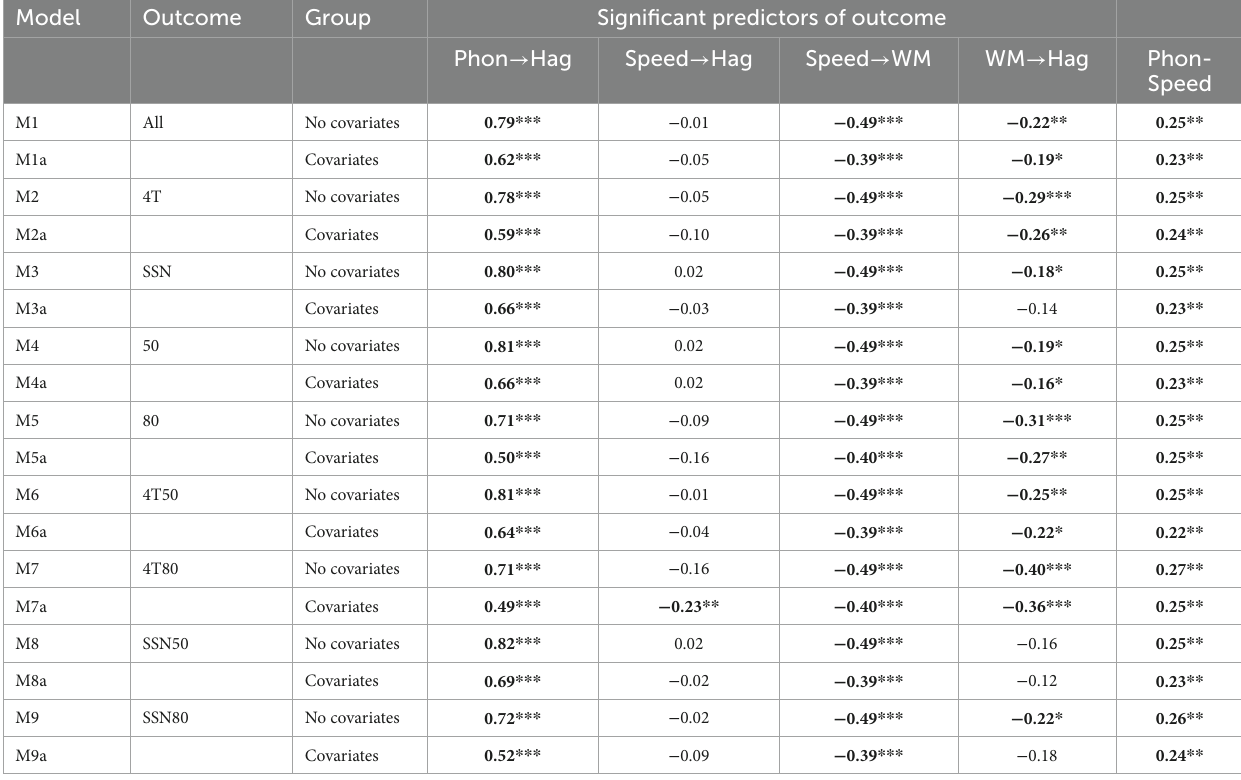
TABLE 4 Results of mediation analyses.